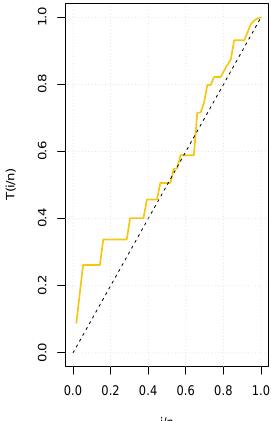
Figure 5. TTT plot for the student enrollment dataset.